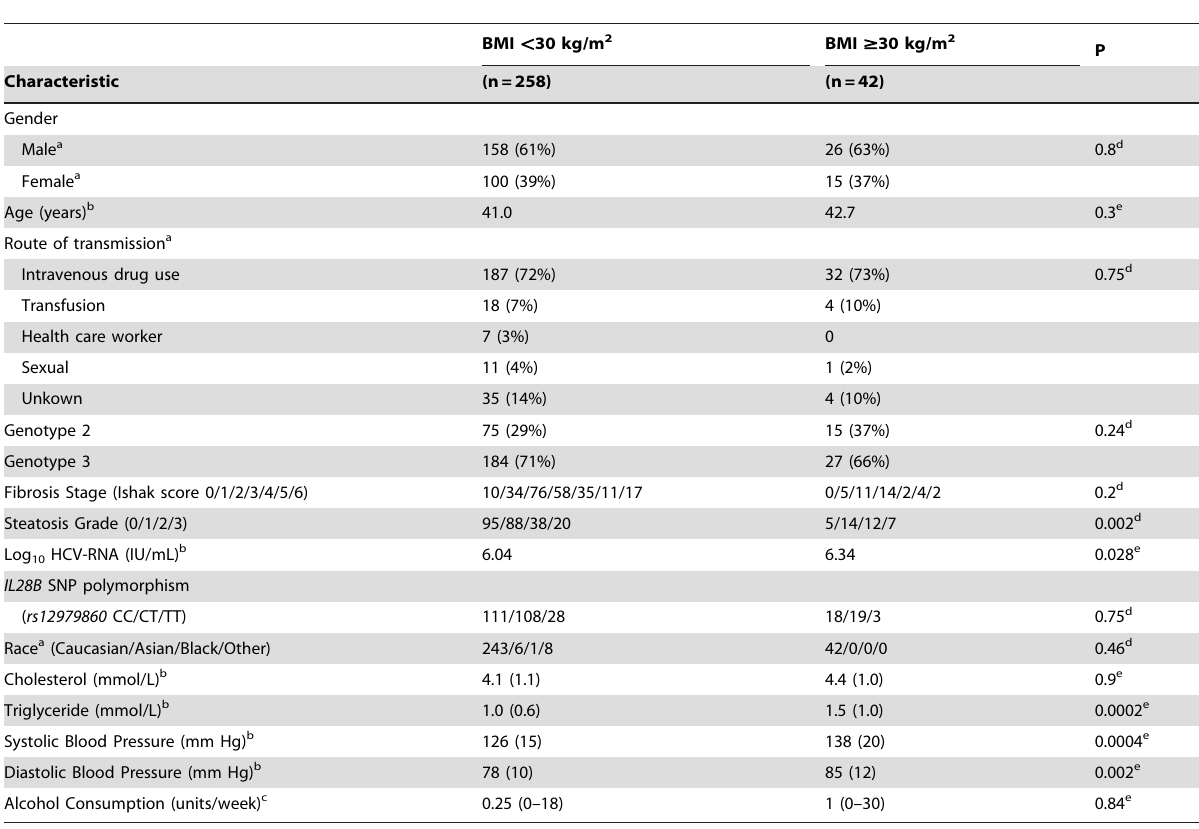
Table 1. Baseline Characteristics of the Patients Grouped by BMI (Per-Protocol